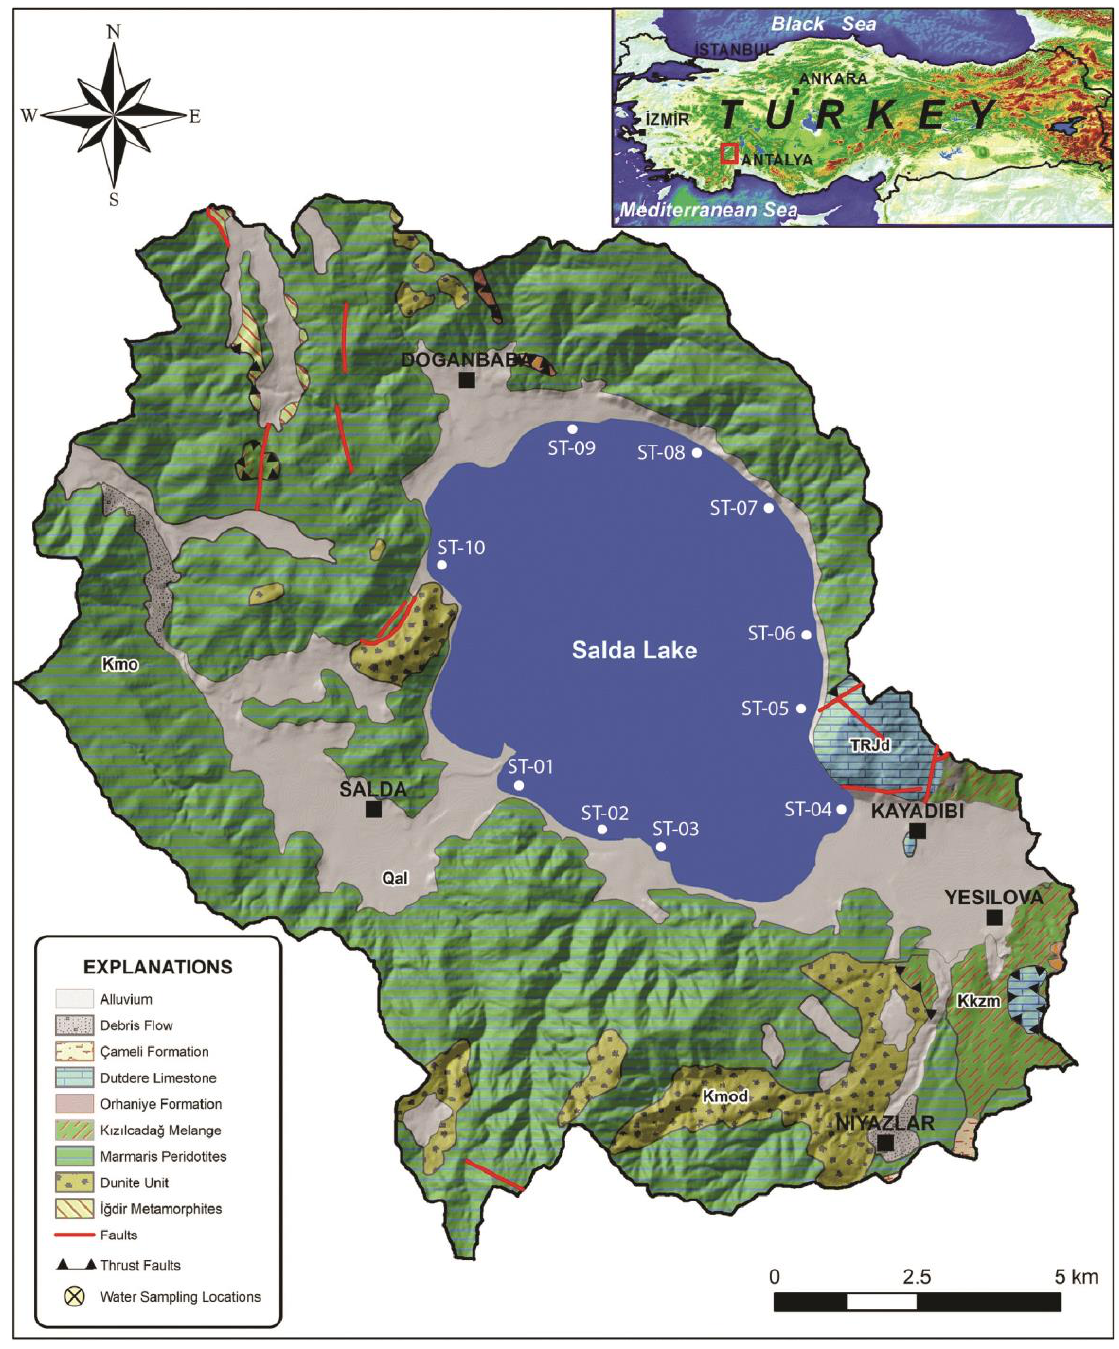
Figure 1. The geological map of the Lake Salda, SW Turkey. Adapted from Davraz, et al. [51] .